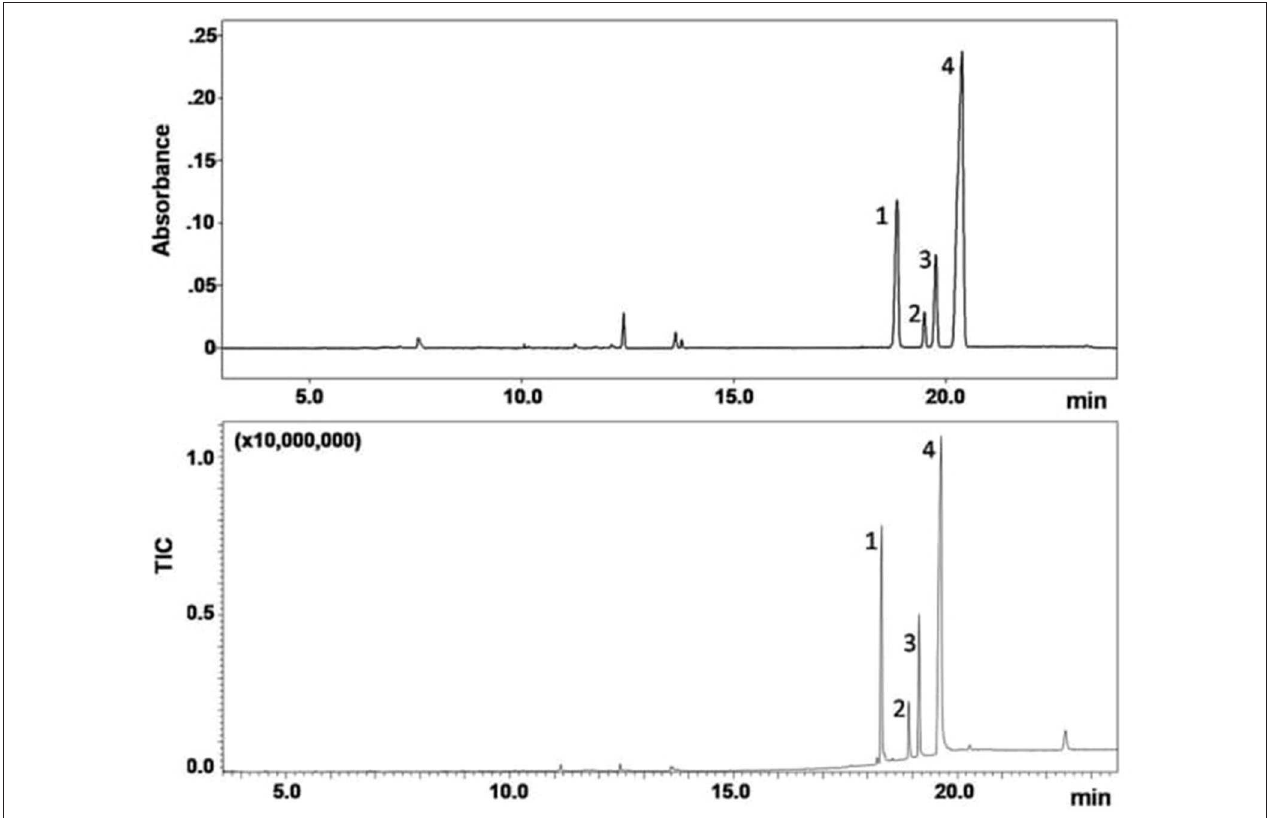
FIGURE 5 | GC-FTIR (top) and GC-EI-MS (bottom) analysis of a seized sample. Column: SLB-5ms (30m L × 0.25mm i.d., 0.25 µ m d f ), carrier gas: helium at 1.1 mL/min (30 cm/s, 109 kPa); oven: 100 ◦ C for 2min, to 350 ◦ C at 15 ◦ C/min (held for 5.0min); injection: 1 µ L splitless (GC-FTIR) or 0.3 µ L split 1:50 (GC-MS) at 280 ◦ C. Peak identification: JWH-250 (1), JWH-015 (2), JWH-073 (3), JWH-018